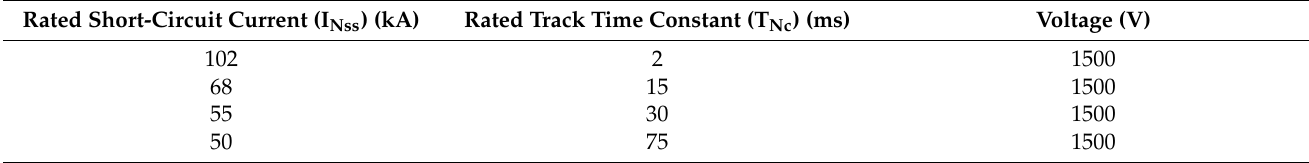
Table 16. Alstom ARC1550 DCCB breaking capacity data [28].